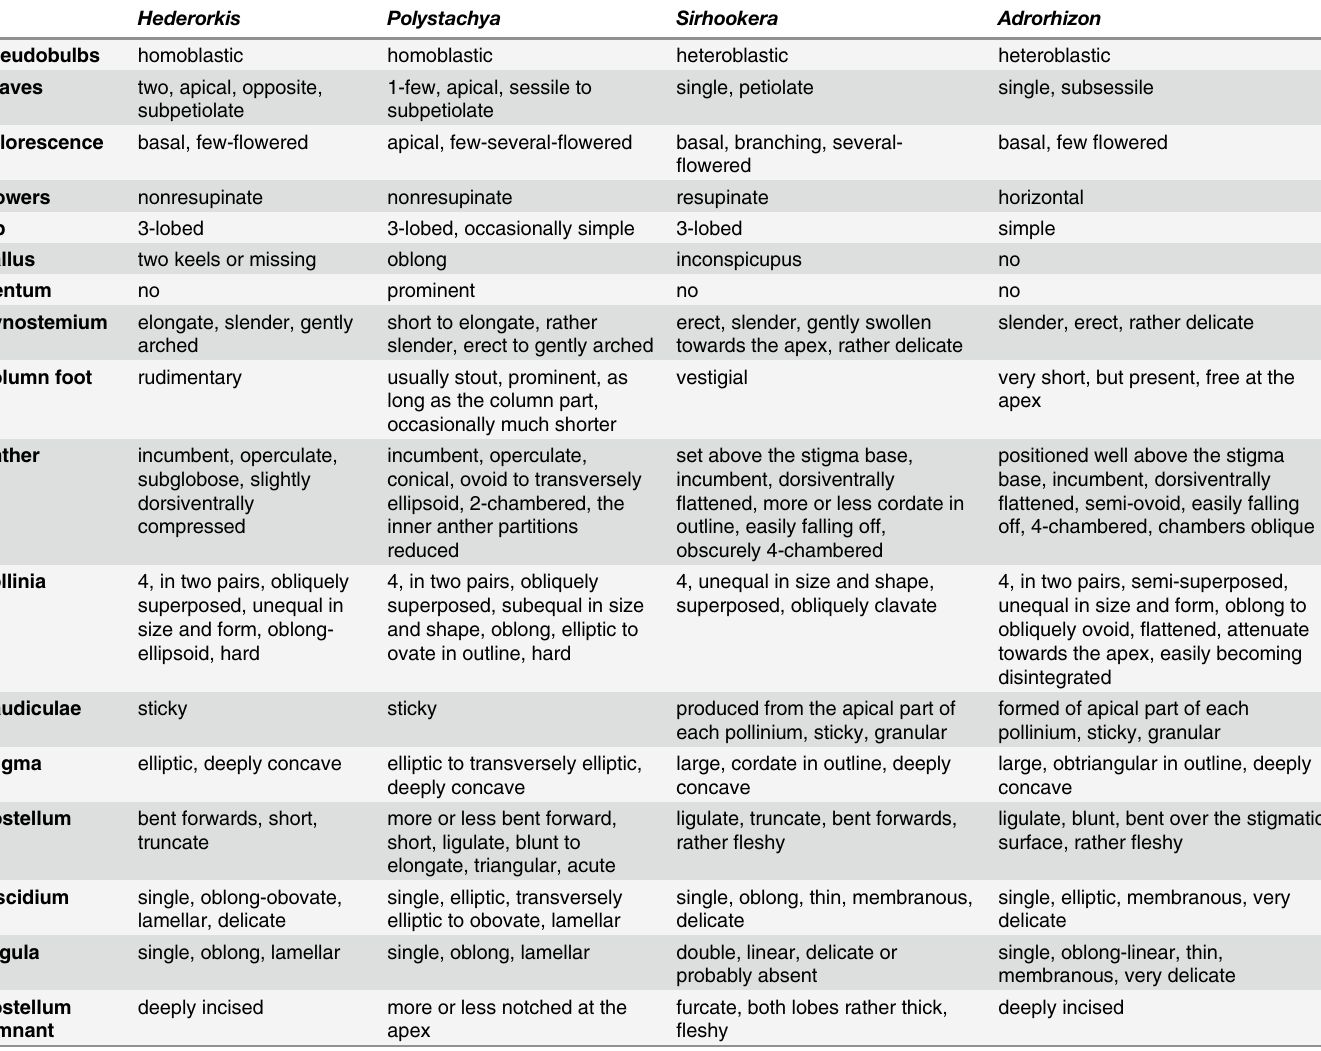
Table 2. The comparison of the morphological characters of Hederorkis Thouars, Polystachya Hook., Sirhookera Kuntze and Adrorhizon Hook.f. in